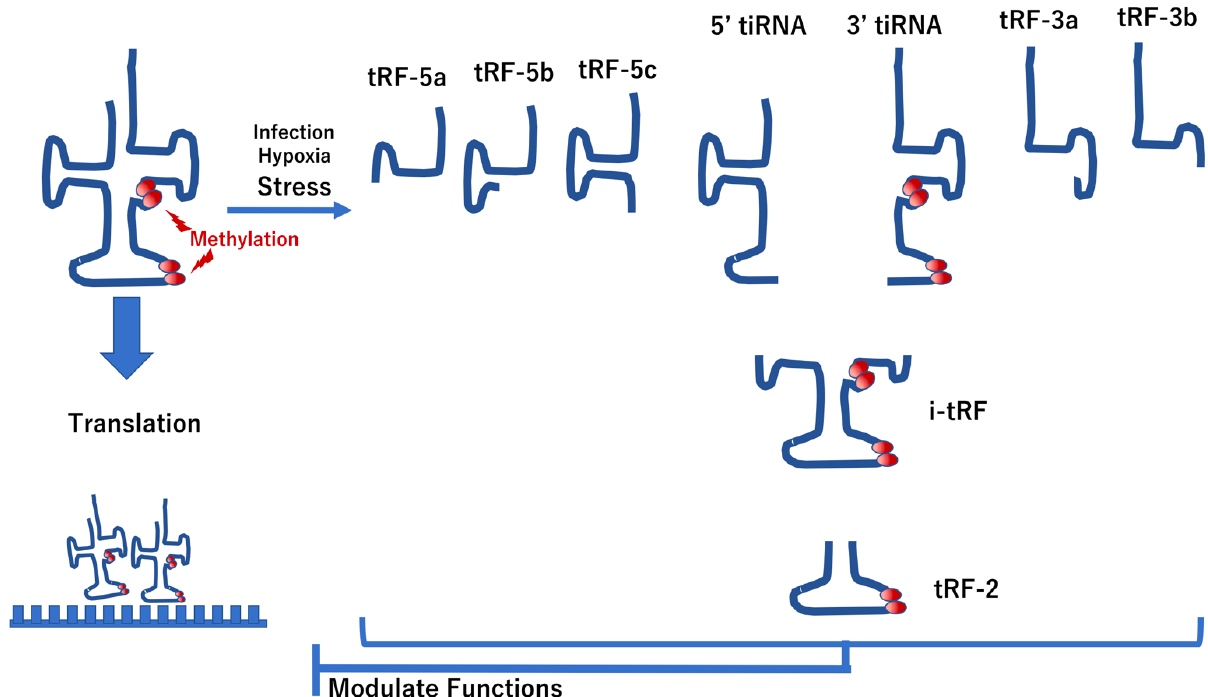
Figure 4. RNAs, their modification and their functions in stress. Under stress (e.g., hypoxia, viral or bacterial infections), the production of tRNA-derived stress-induced RNAs (e.g., 5′ -tiRNA and 3′ -tiRNA) occurs via enzymatic cleavage of tRNAs. This cleavage also leads to the generation of tRNA-derived RNA fragments (tRFs), which are involved in the modulation of translation function of standard tRNAs. Several positions in tRNAs are methylated, where such methylation modulates tRNA functions.